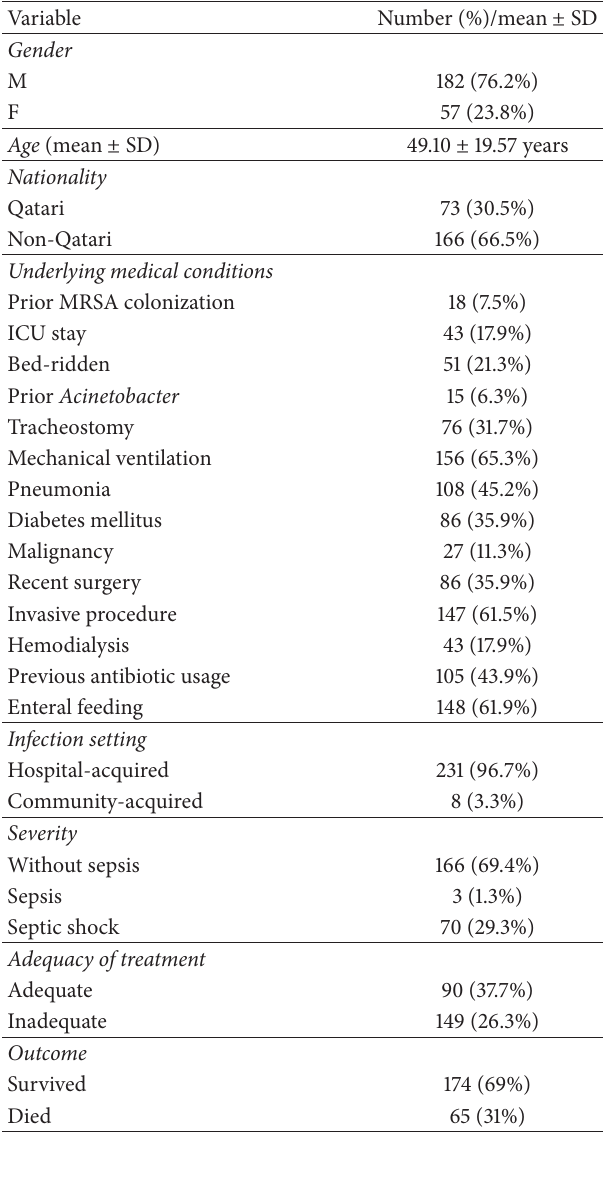
Table 2: Number of isolates among different age groups.